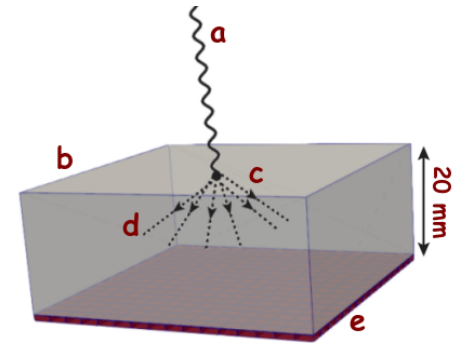
Figure 2. Schematical representation of an incident gamma ray (a) that interacts with a scintillating crystal (b) of typical size (50 × 50 × 20 mm 2 ) at the point (c), producing optical photons (d)